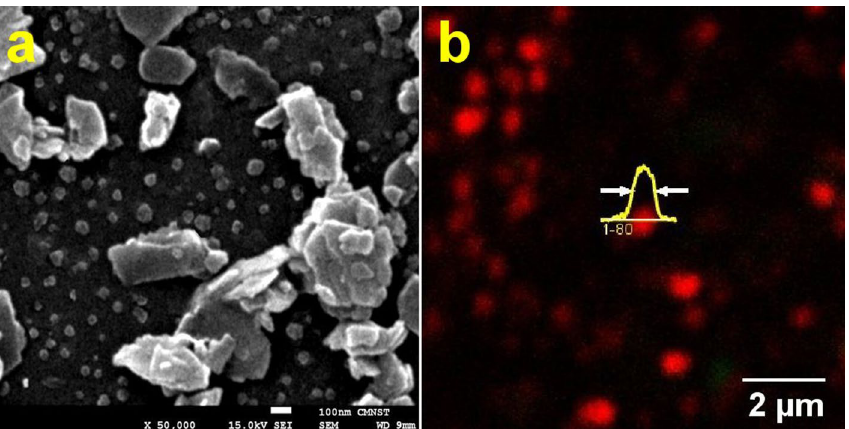
Figure 1. SEM ( a ) and SHG images ( b ) of CZ nanoparticles. The intensity profile of the individual nanoparticle along the center is shown in yellow. Scale bars represent 100 nm ( a ) and 2 µm ( b ). Excitation wavelength: 780 nm, objective: 40×/NA